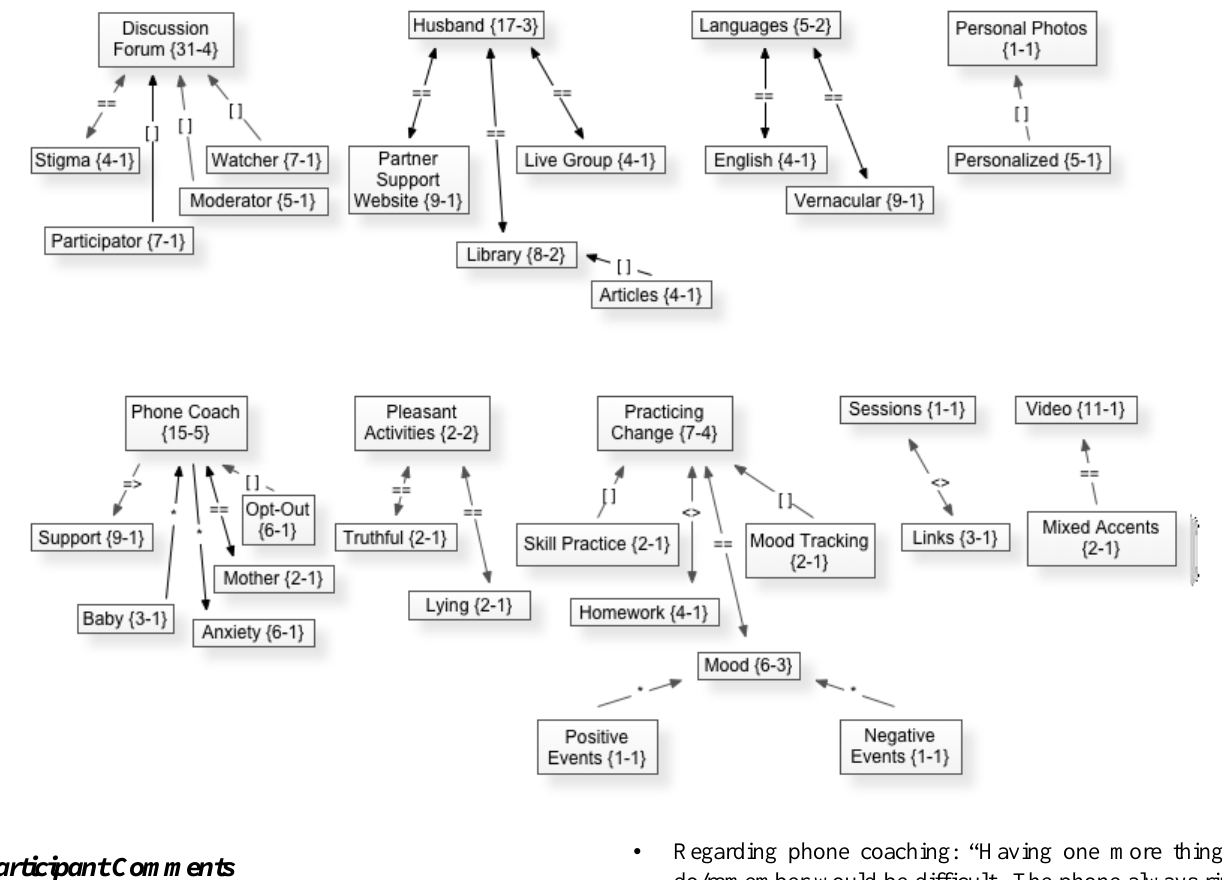
Figure 1. Mock-up of Atlas.ti network view diagram of focus group participant comments showing theme of